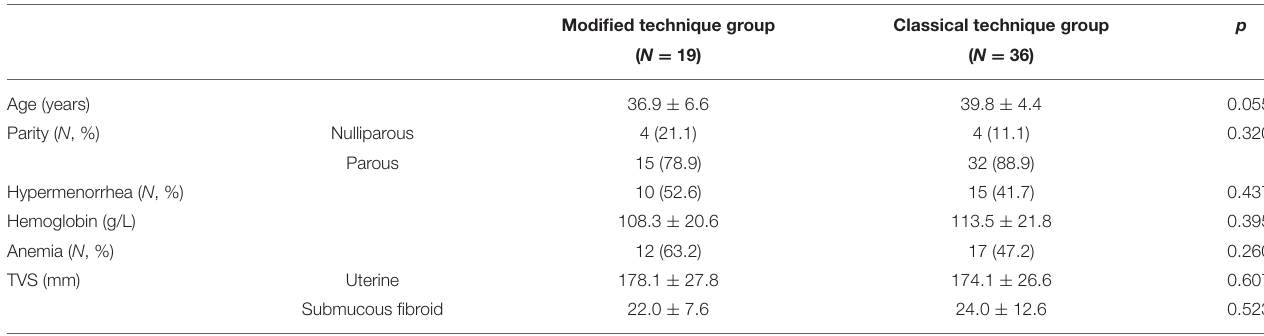
TABLE 1 | Baseline data of patients in the